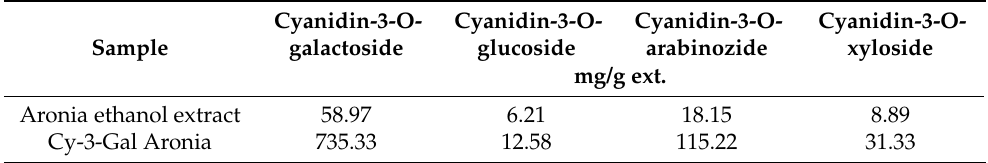
Table 2. Anthocyanin quantities identified in extract and cyanidin-3-O-galactoside fraction of Aro- nia melanocarpa berries.